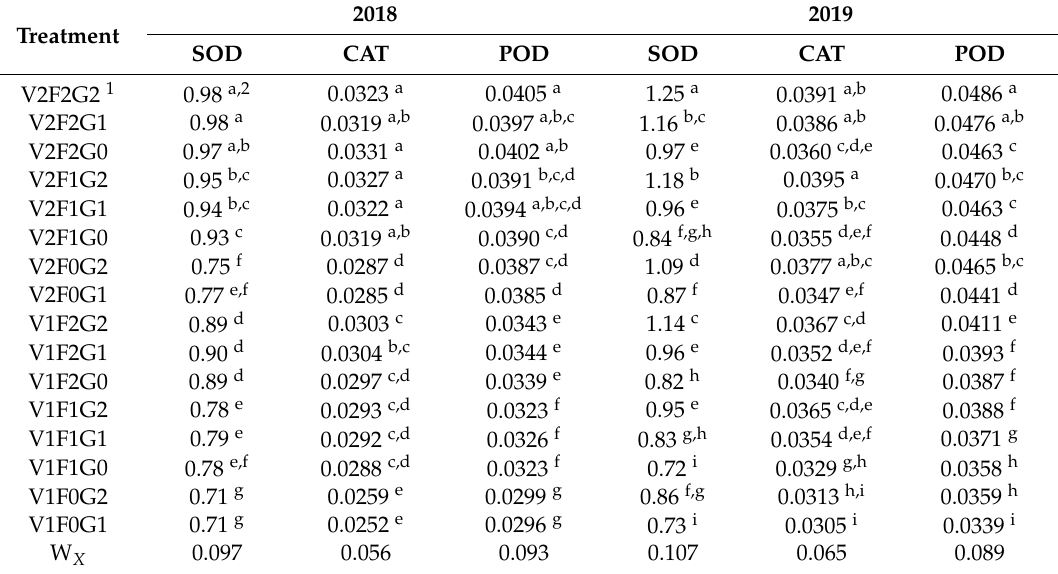
Table 7. Activities (U mg − 1 protein) of superoxide dismutase (SOD), catalase (CAT), and peroxidase (POD) of hybrid maize seeds under di ff erent irrigation treatments and weight determined using the entropy weight method (W X ) in 2018 and